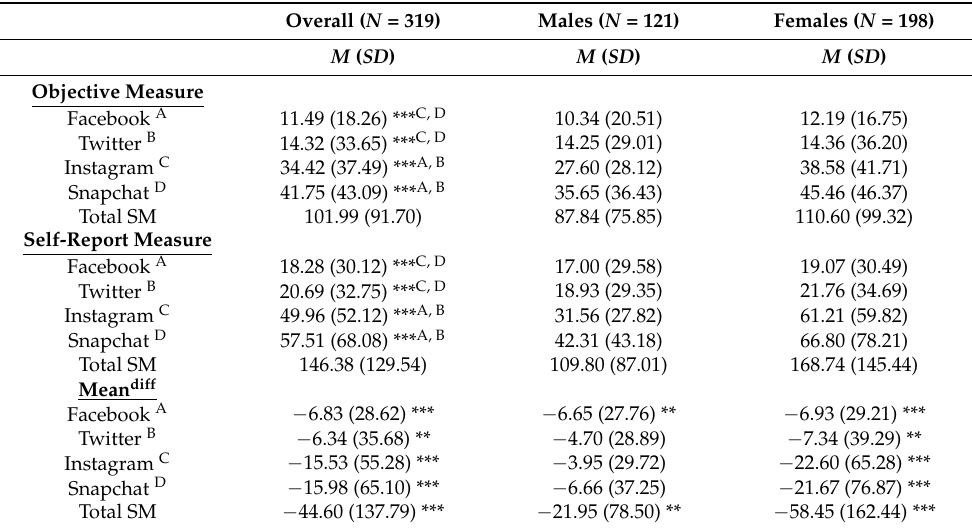
between measures overall and by